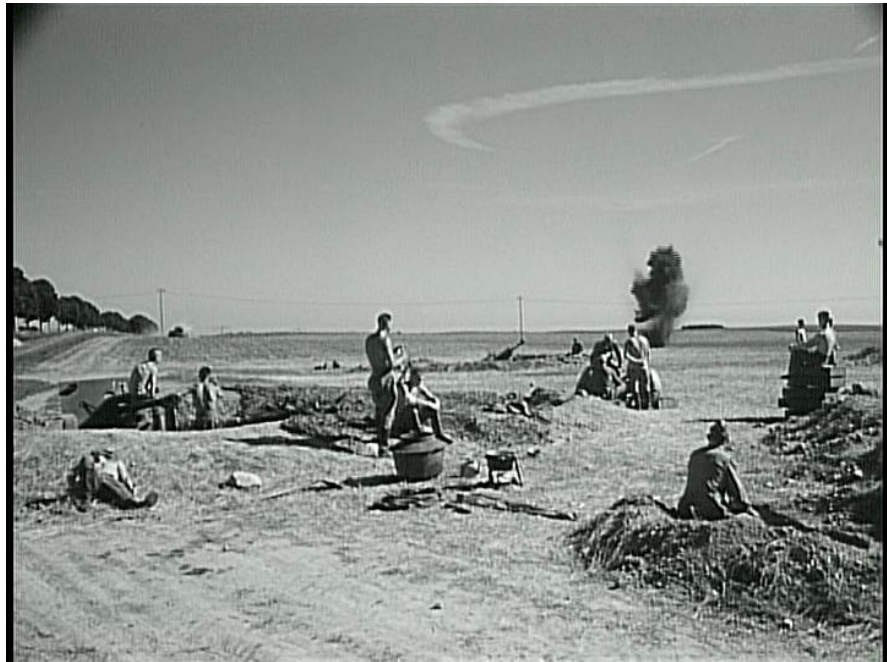
Figure 3. SS-militants in Red Army tanks shoot at the resting soldiers. The serene landscape as a place of deception and senseless